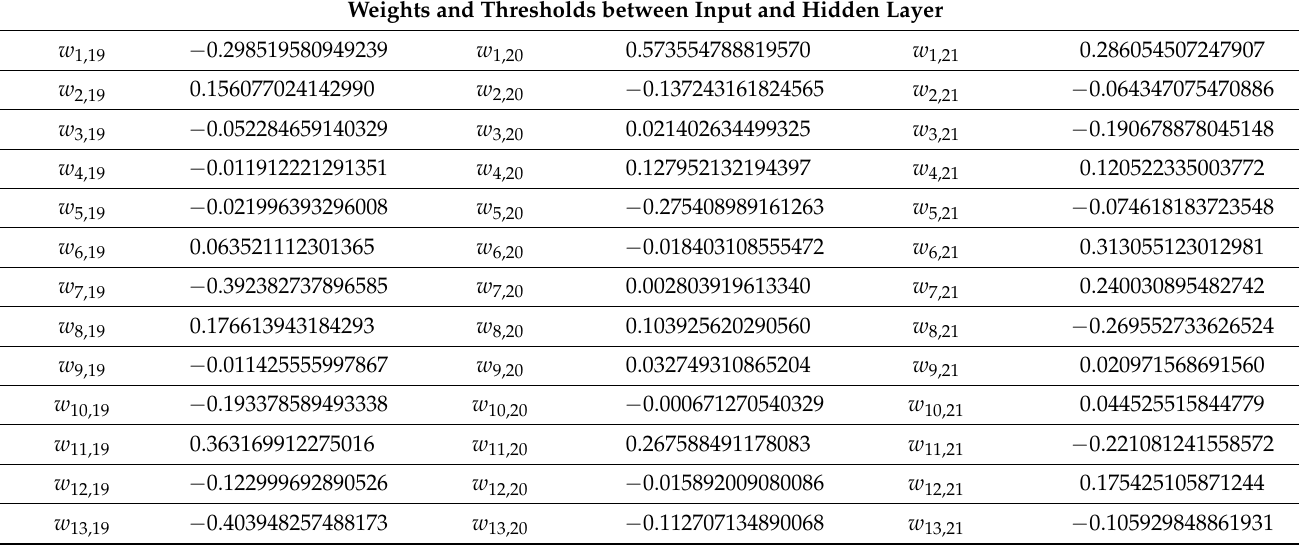
Table 4. Weights and threshold values for db6 wavelet neural network classifier. Weights and Thresholds between Input and Hidden